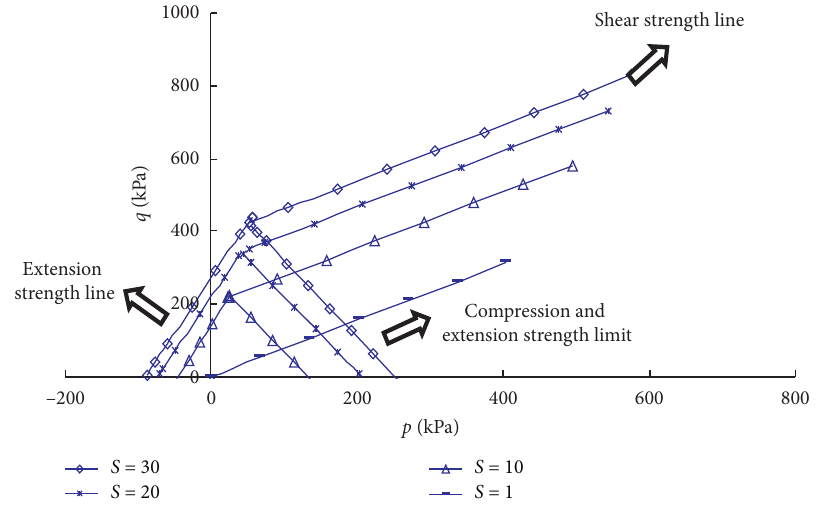
Figure 19: Modified Mohr–Coulomb failure plane.